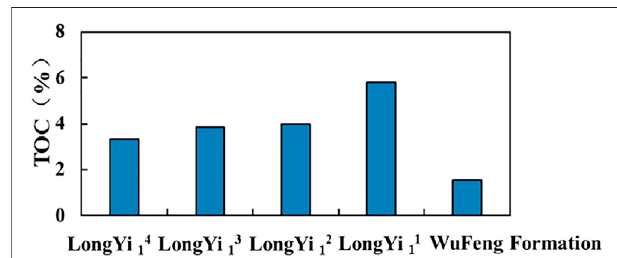
FIGURE 2 | Average TOC content of each layer.